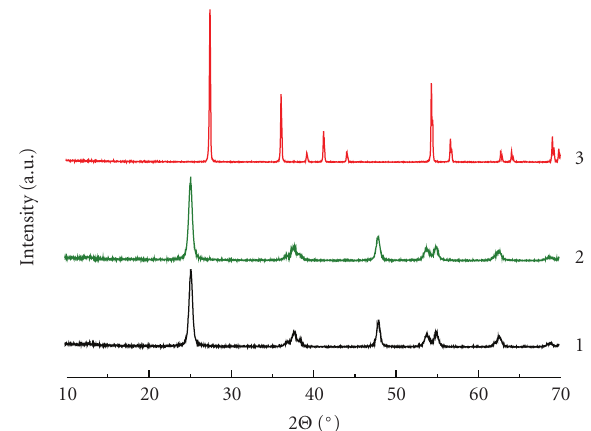
Figure 1: XRD patterns of the starting TiO 2 (sample A)